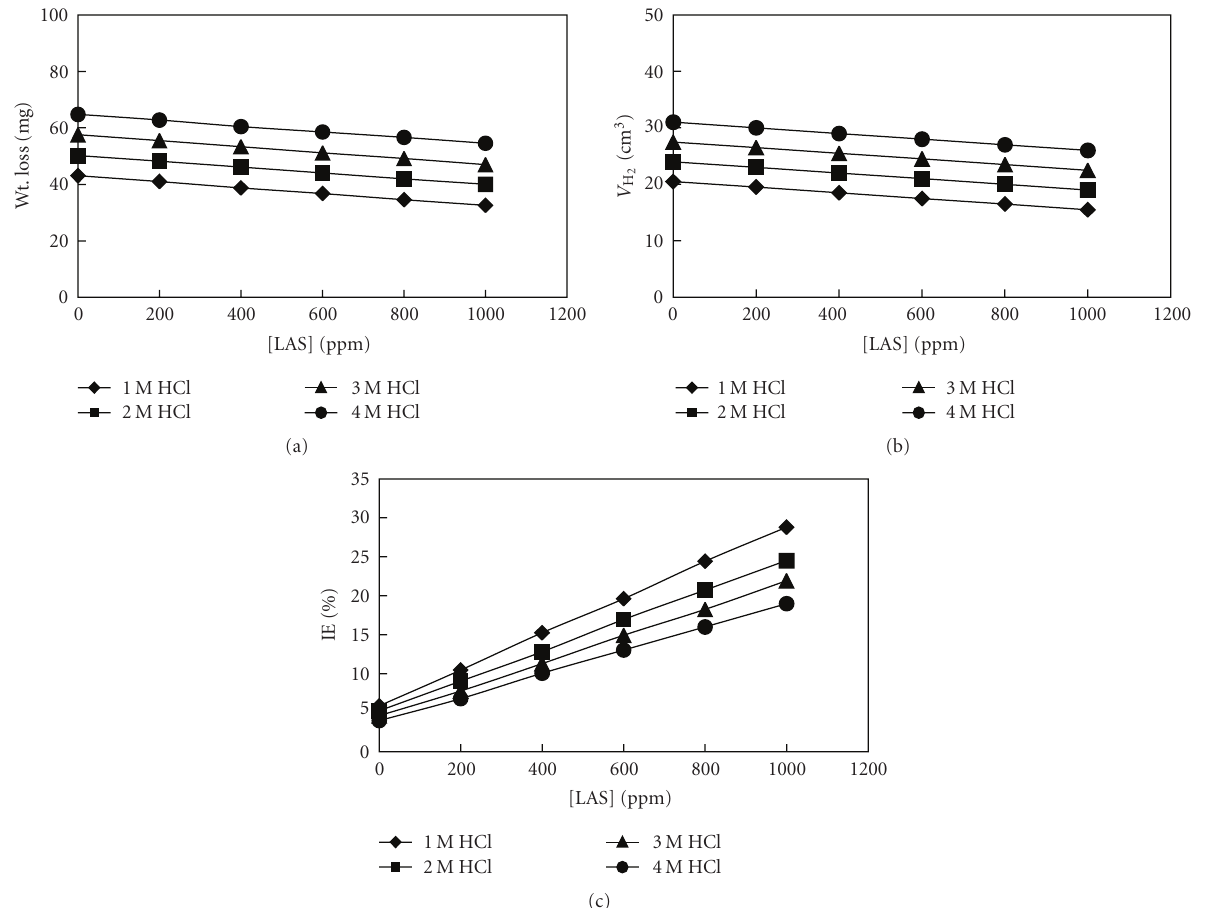
Figure 2: Change of (a) weight loss, (b) Volume of H 2 gas, and (c) Inhibition e ffi ciency (%IE) with LAS concentration using di ff erent HCl concentrations in presence of magnetic field for 1.0 hour exposure at 20 ◦